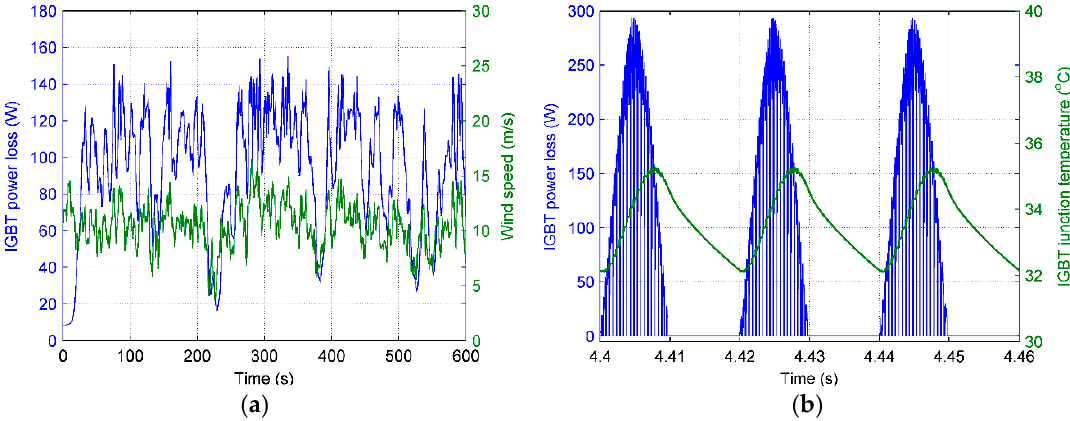
Figure 3. Wind speed and insulated-gate bipolar transistor (IGBT power losses: ( a ) averaged by the fundamental frequency vs. time; ( b ) instantaneous IGBT power losses and junction temperature in the steady state. Table 1. Properties of the materials in the model.